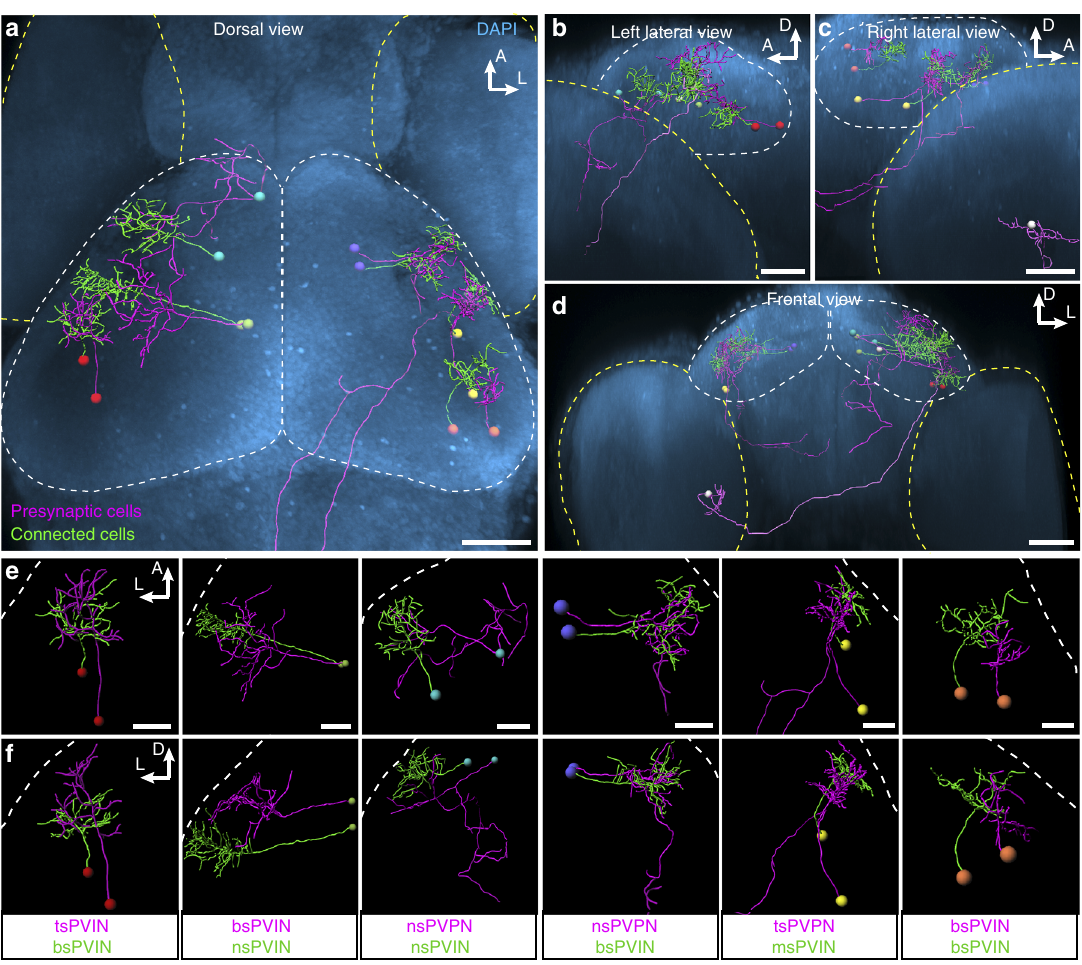
Fig. 8 Registration of Optobow fi sh highlights relative anatomical positions of connected cell pairs. a – d Registration of six identi fi ed cell pairs (illustrated by the same cell body color) into one reference brain (outlined by DAPI). Shown are dorsal ( a ), lateral ( b and c ) and frontal views ( d ). Optic tecta are outlined by white , and eyes by yellow dashed lines , respectively. The RGC-PVIN cell pair (white cell bodies) described in Fig. 6 was added in b – d . Scale bar , 50 µ m. e , f Dorsal ( e ) and transverse views ( f ) of single cell pairs shown in a – d . White dashed lines outline skin. Identi fi ed cell types are indicated below. Scale bar